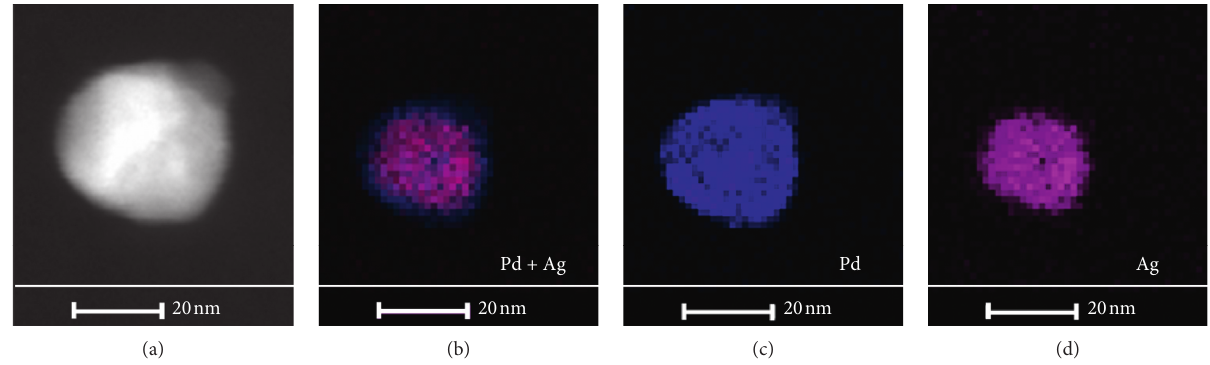
Figure 4: (a) STEM image of PdAg-acac-4 single nanoparticle and EDX element distribution maps of Ag +Pd (b), Pd (c), and Ag (d) in singular nanoparticle.